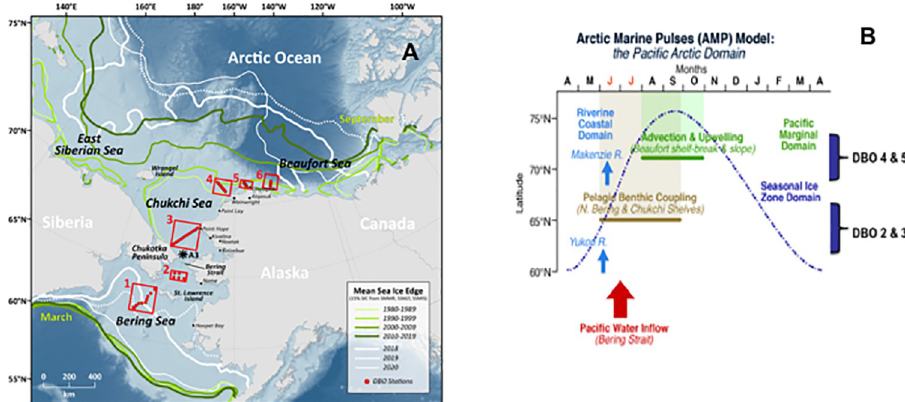
Fig 2. The Distributed Biological Observatory (DBO) and mean sea ice edge in the Pacific Arctic (A, revised from [10]), and a schematic of the conceptual Arctic Marine Pulses model (B, revised from [29]) depicting links among biophysical aspects of the Pacific Arctic marine ecosystem. The mean sea ice edge depicts the 15% concentration threshold using SMMR, SSM/I and SSMIS satellite data. All sea ice edge contours north (south) of Bering Strait represent September (March) conditions for three decadal periods (green) and annually for 2018, 2019 and 2020 (white).